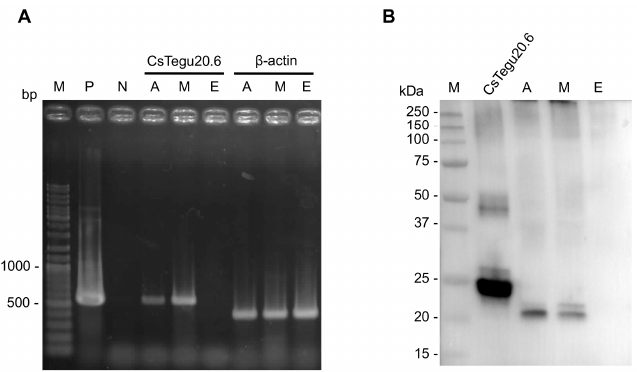
Figure 9. Transcriptional and protein analysis of CsTegu20.6 across C. sinensis developmental stages. ( A ) PCR was performed using specific primers for the complete coding sequence of CsTegu20.6;